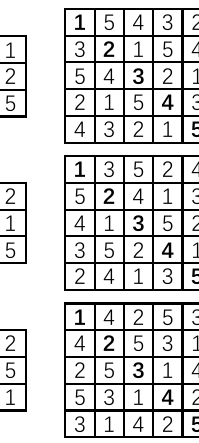
Figure 3. Construction of MOLS of order 5. If there is a column ( a , b , c ) T in a table on the left, fill it in with number c at the cell at row a and column b in the corresponding square on the